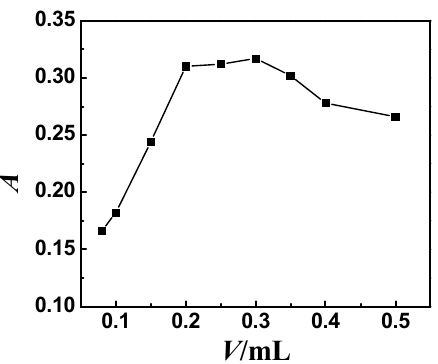
Figure 2. E ff ect of the amount of 5-Br-PADAM on absorbance (peak area). Thirty nanograms Ni; 1.0 mL 0.5% ( m / v ) SLS; 0.8 mL 1.0% ( m / v ) Triton X-114; temperature: 60 °C; heating time: 10 min; pH = 5.0.